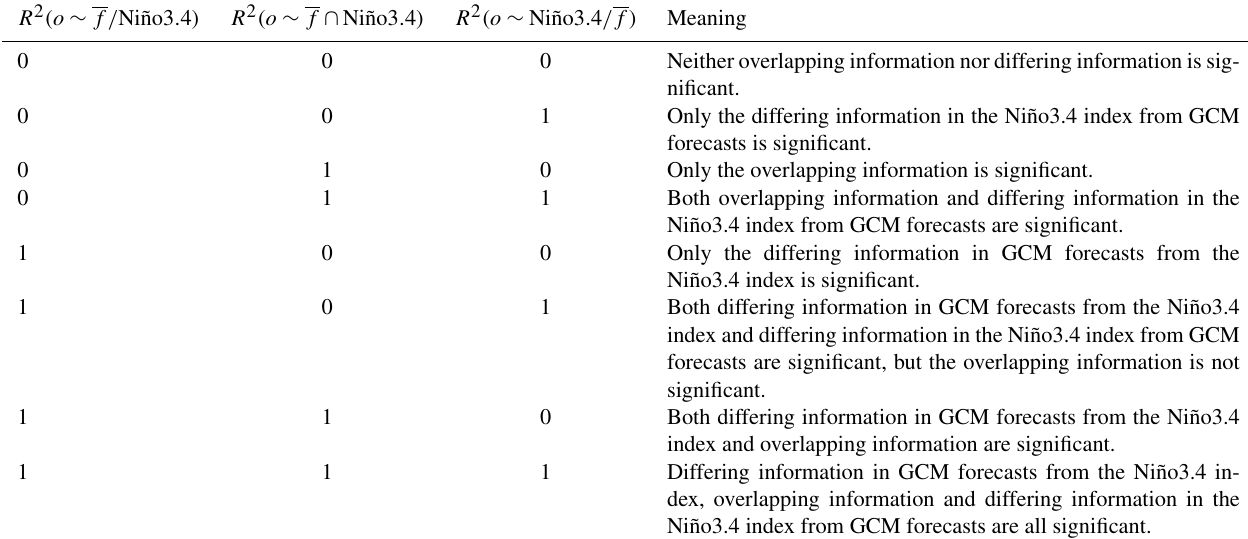
Table 1. Three-digit representations of the eight patterns of overlapping and differing information. R 2 (o ∼ f / Niño3 . 4 )